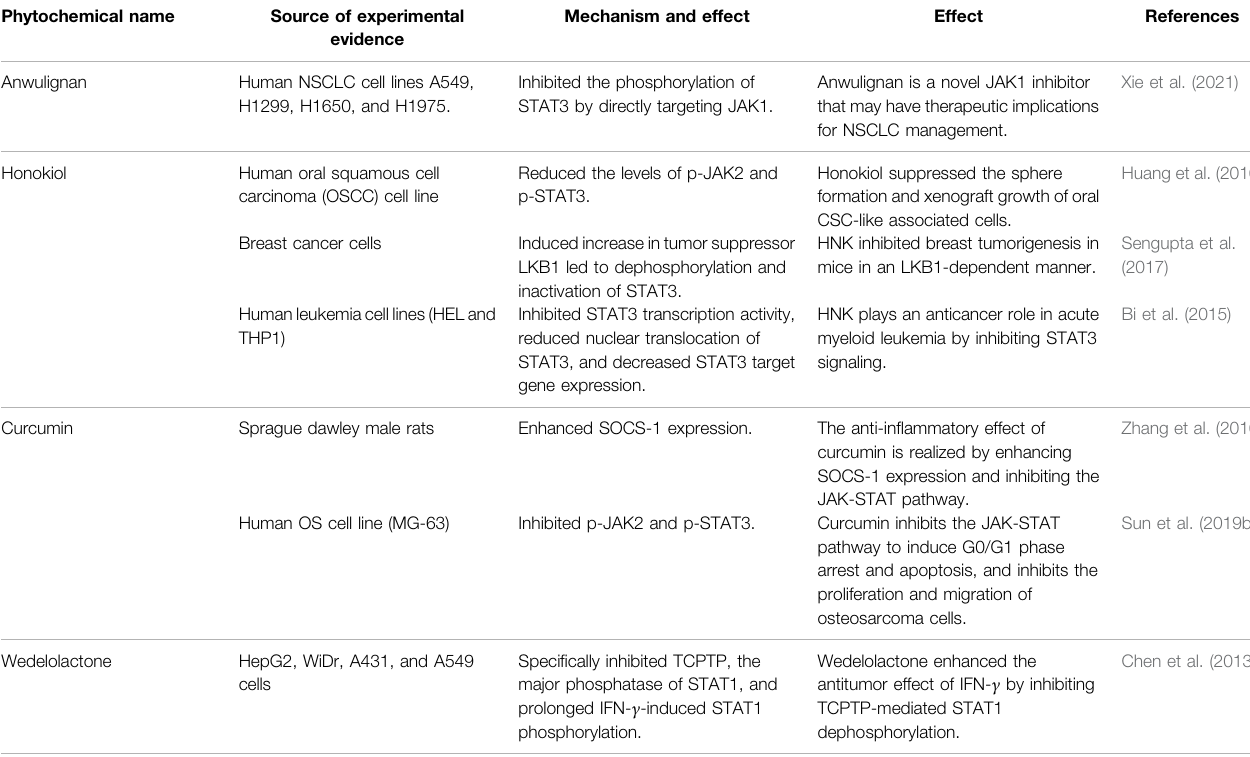
TABLE 2 | ( Continued ) Pharmacological effects of polyphenol phytochemicals on the JAK-STAT signaling